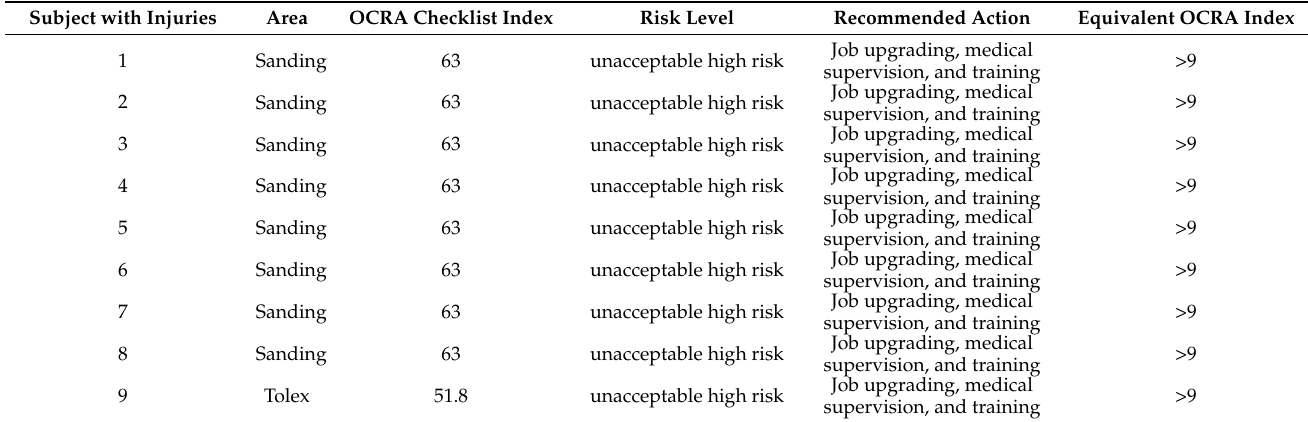
Table 6. Results of the OCRA assessment conducted in the study